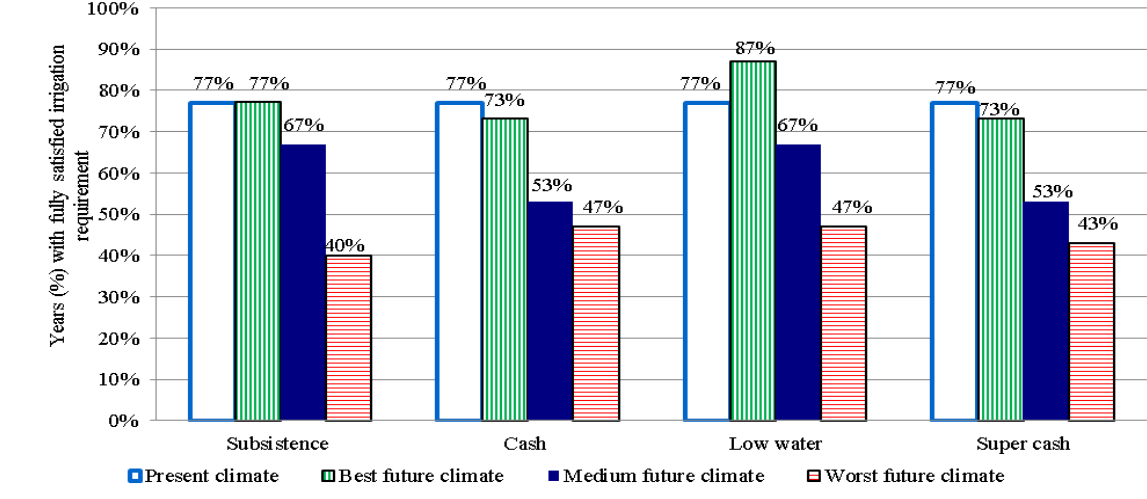
Figure 8. Proportion of years (%) with fully satisfied irrigation requirements leading to full yield, without adaptation measures. The garden area is optimized for current climate conditions (a satisfaction of irrigation requirements in 77% of years refers to a probability of 3 out of 4 years, equal to 7 out of 30 years in the monthly time series).